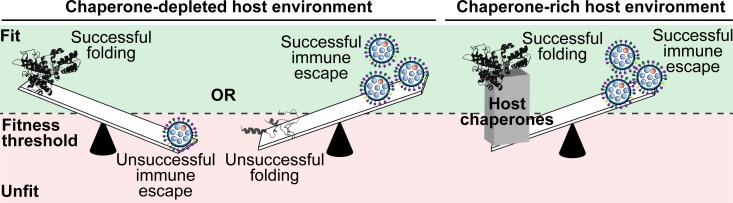
Host chaperones mediate the accessibility of biophysically destabilized adaptive mutations.(Left) Model for a chaperone-depleted environment, in which immune escape and acceptable protein biophysical properties present strongly competing selection pressures. (Right) Model for a chaperone-rich host environment, in which, at least for some viral protein variants, these pressures can be uncoupled as chaperones enable viral proteins to maintain acceptable folding and structural properties while still endowing escape from the immune system.